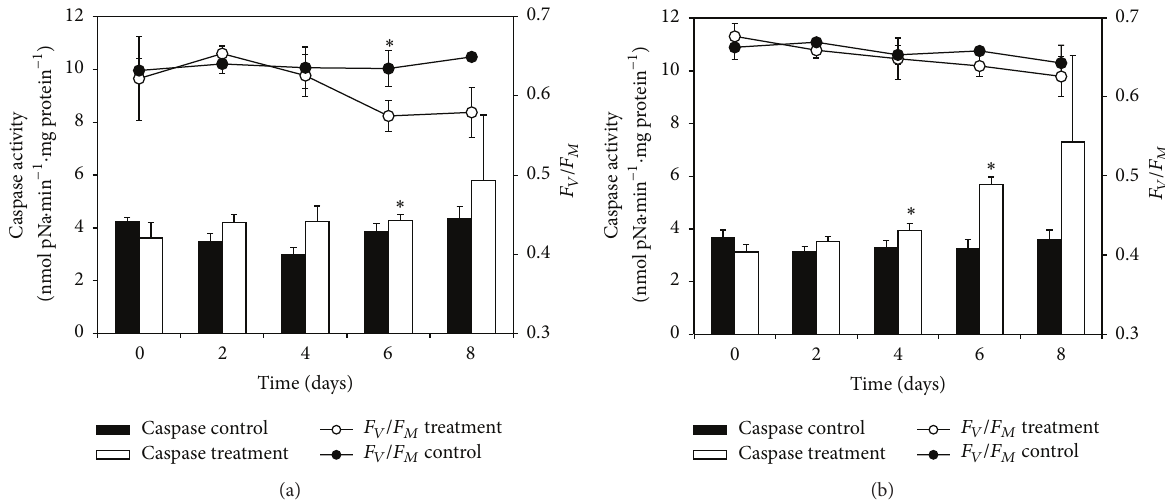
Figure 3: Effect of heat stress on caspase 3 activity and photosynthetic efficiency in Acropora millepora (a) and Pocillopora damicornis . (b). Caspase 3 activity is expressed as percentage of control; PSII efficiency (maximum quantum yield, 𝐹 𝑉 /𝐹 𝑀 ) as measured in situ by Pulse Amplitude Modulated (PAM) fluorometry in corals incubated in control (filled circles) and heat stress treatments (open circles). Error bars represent SD; 𝑛 = 3 coral branches for caspase 3 activity and 𝑛 = 3 coral branches for PAM fluorometry. ∗ Significant difference (post hoc LSD analysis, 𝑝 = 0.05 ) between treatment and control for the same time